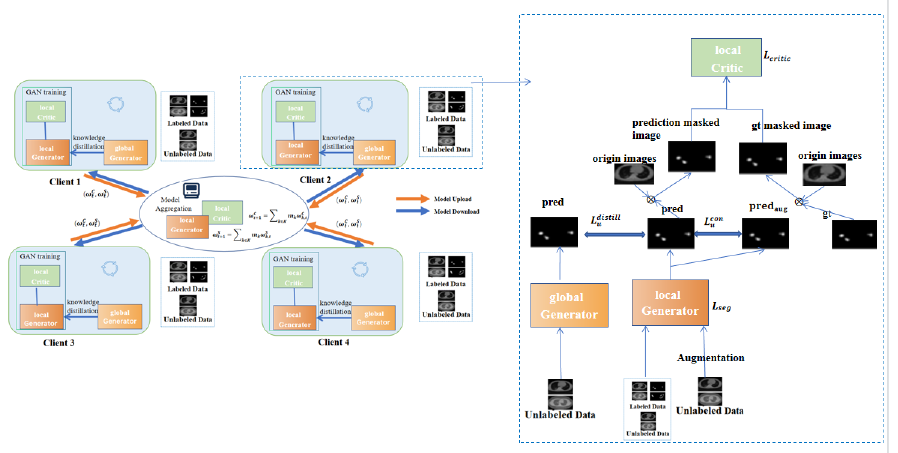
Figure 3. An overview of the privacy-preserving generative adversarial network framework (MixFedGAN) that deals with COVID-19 CT labeled and unlabeled data from four regions using federated